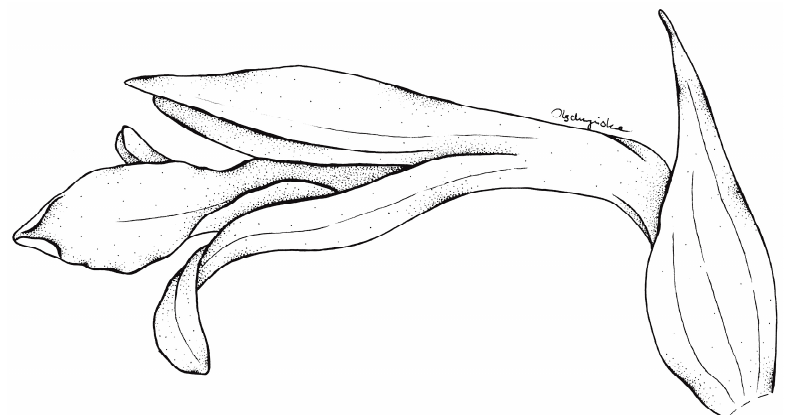
Figure 6. Flower of Schiedeella crenulata—drawn from the holotype (Forderstrom 2592, deposited at AMES). Drawn by N.